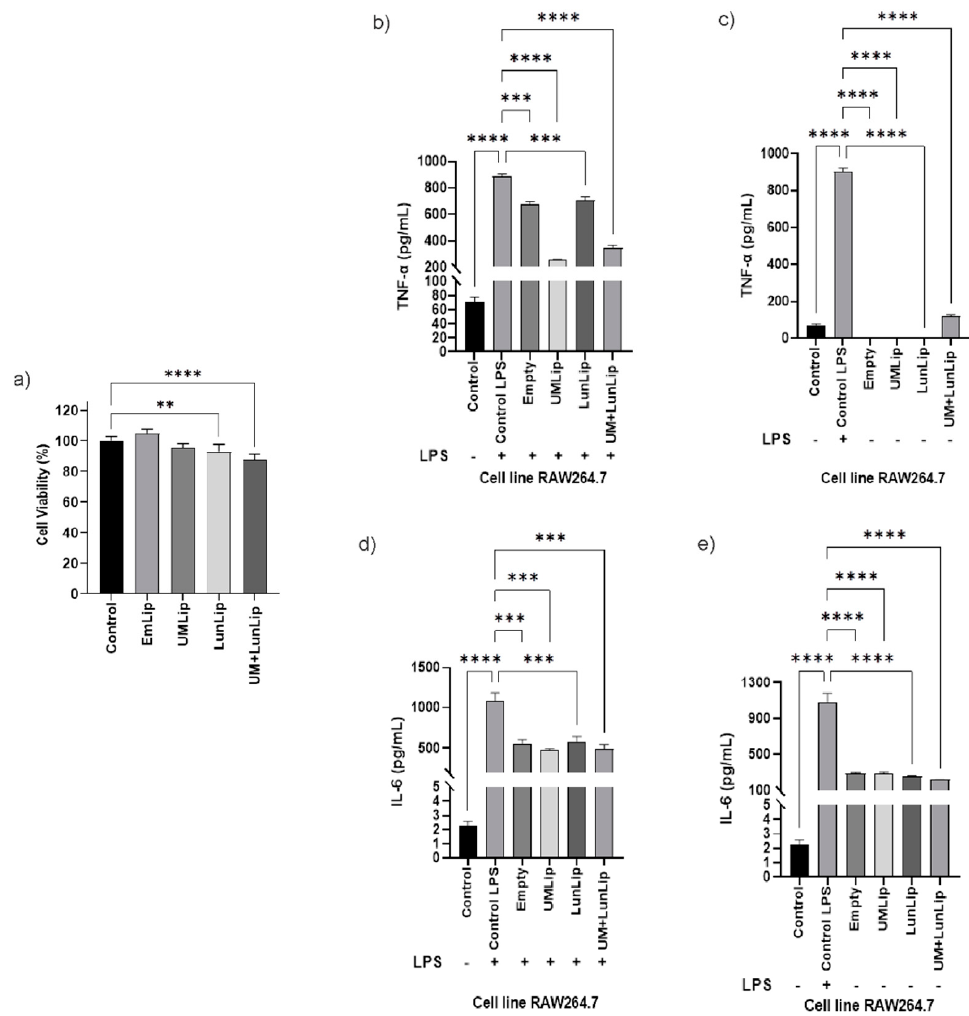
Figure 4. Liposomes prepared with dioleoyl phosphatidylcholine and dioleoyl phosphatidylglycerol, and loaded with soybean lunasin and amaranth unsaponifiable matter (UM + LipLun) decreased TNF- α and IL-6 production after LPS stimulation of RAW 264.7 macrophages. ( a ) Cell viability of RAW 264.7 macrophages after treatment with empty liposomes (EmLip), unsaponifiable matter-loaded liposomes (UMLip), lunasin-loaded liposomes (LunLip), and UM + LunLip. ( b ) TNF- α expression after treatment with liposomes to LPS-stimulated RAW 264.7 macrophages. ( c ) TNF- α expression after treatment with liposomes to non-LPS-stimulated RAW 264.7 macrophages. ( d ) IL-6 expression after treatment with liposomes to LPS-stimulated RAW 264.7 macrophages. ( e ) IL-6 expression after treatment with liposomes to non-LPS-stimulated RAW 264.7 macrophages. All the treatments consisted of 2 mg lunasin/mL or its equivalent in UMLip and EmLip. ** p < 0.05; *** p < 0.001; **** p < 0.0001.